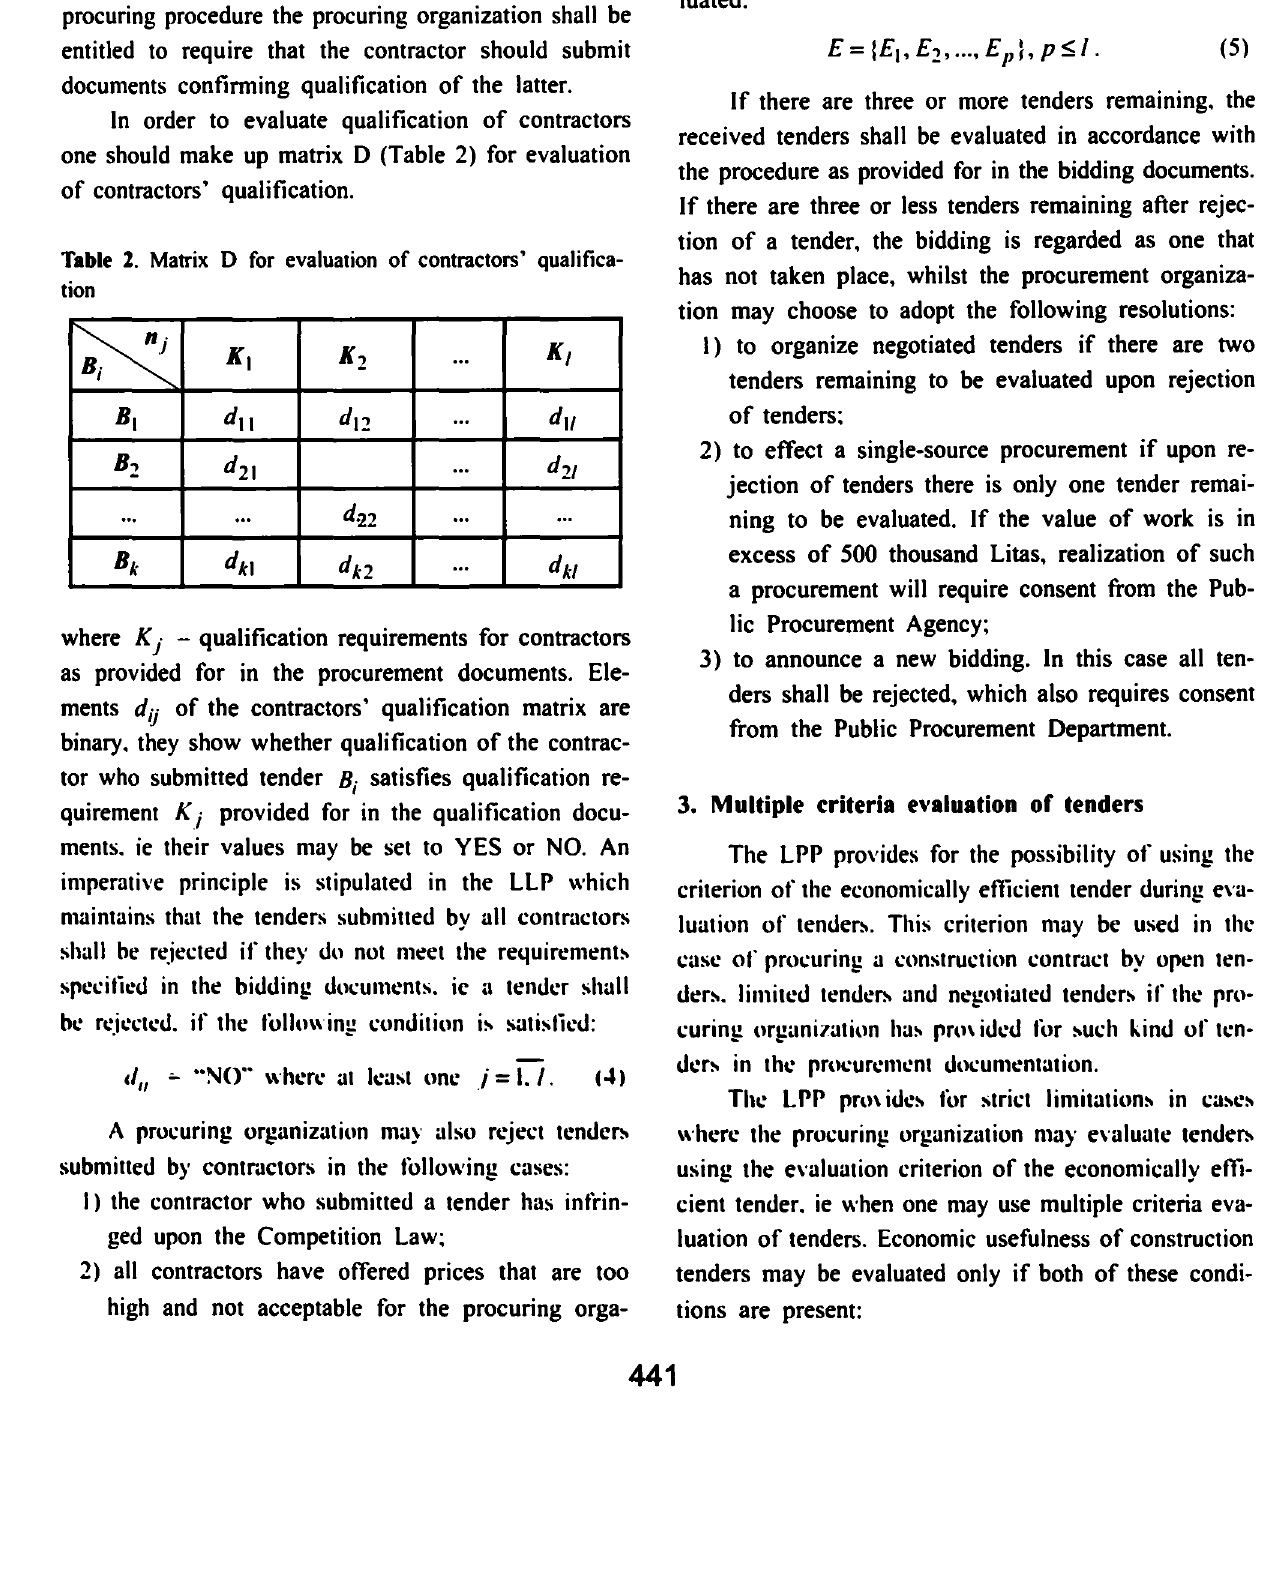
Table l. Matrix D for evaluation of contractors'